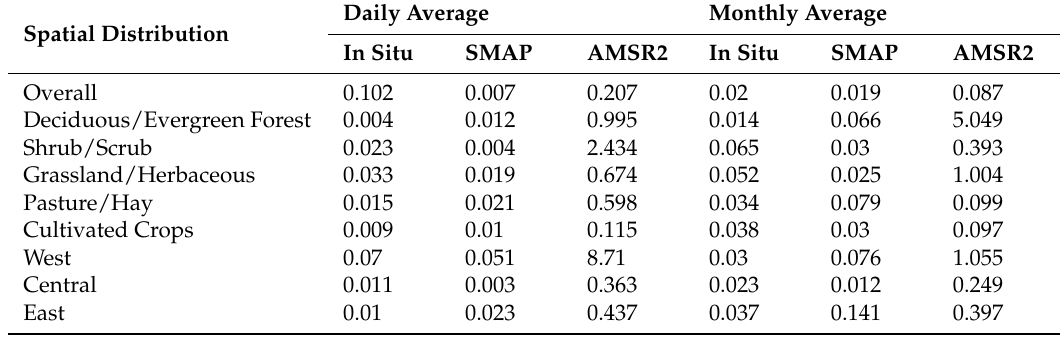
Table 3. Estimated errors of the in situ, SMAP, AMSR2 soil moisture dataset for different spatial distribute with the triple collocation (TC) method.